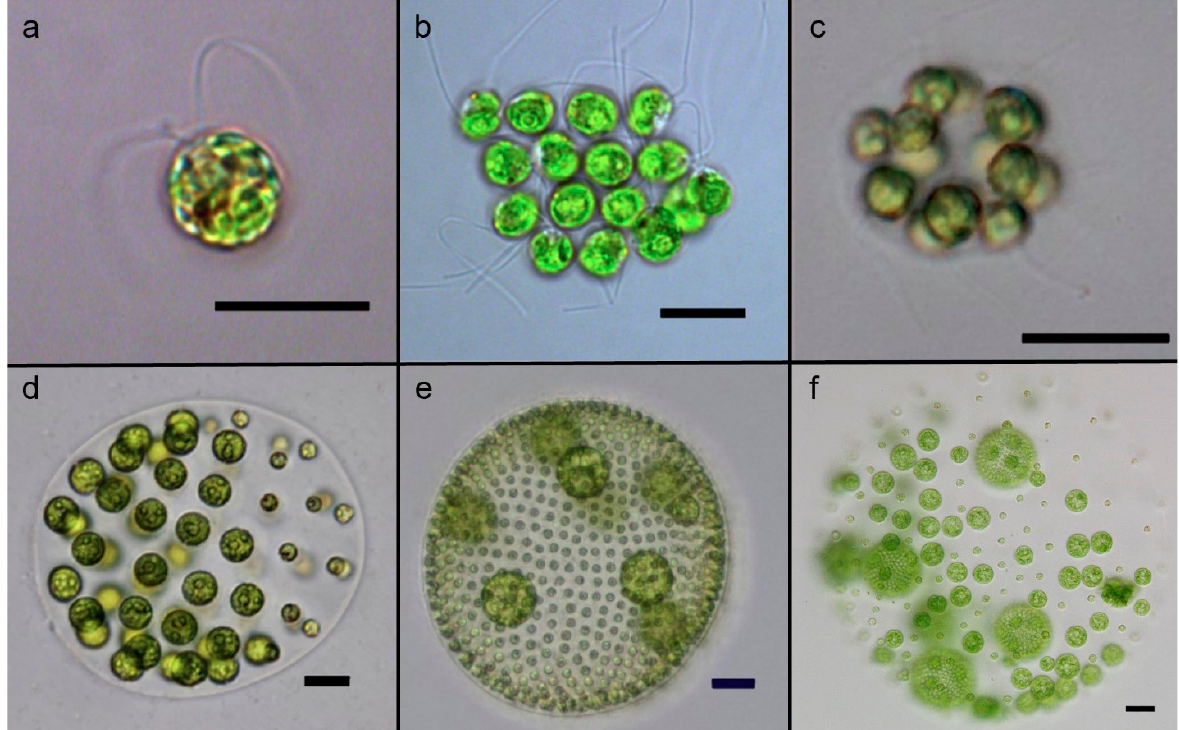
Figure 1. Select species illustrating volvocine green algae diversity in complexity and individuality. ( a ) Chlamydomonas reinhardtii (scale bar 10 µm), ( b ) Gonium pectorale (scale bar 10 µm), ( c ) Eudorina elegans UTEX 1212 (scale bar 10 µm), ( d ) Pleodorina californica (scale bar 25 µm), ( e ) V. carteri f. nagariensis (scale bar 50 µm), and ( f ) V. carteri regenerator mutant showing dedifferentiated somatic cells (scale bar 50 µm). Images ( a – e ) reproduced from the study by Grochau-Wright et al. [25].